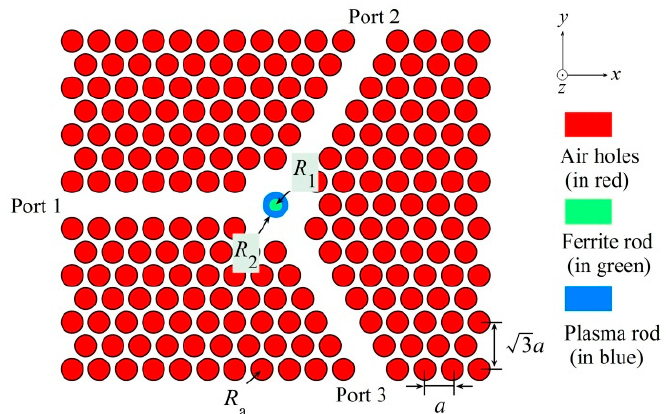
Figure 1. Schematic of the polarization-independent circulator (PIC) structure, where the air holes, ferrite rod, and plasma rod are indicated by red, green, and blue respectively.